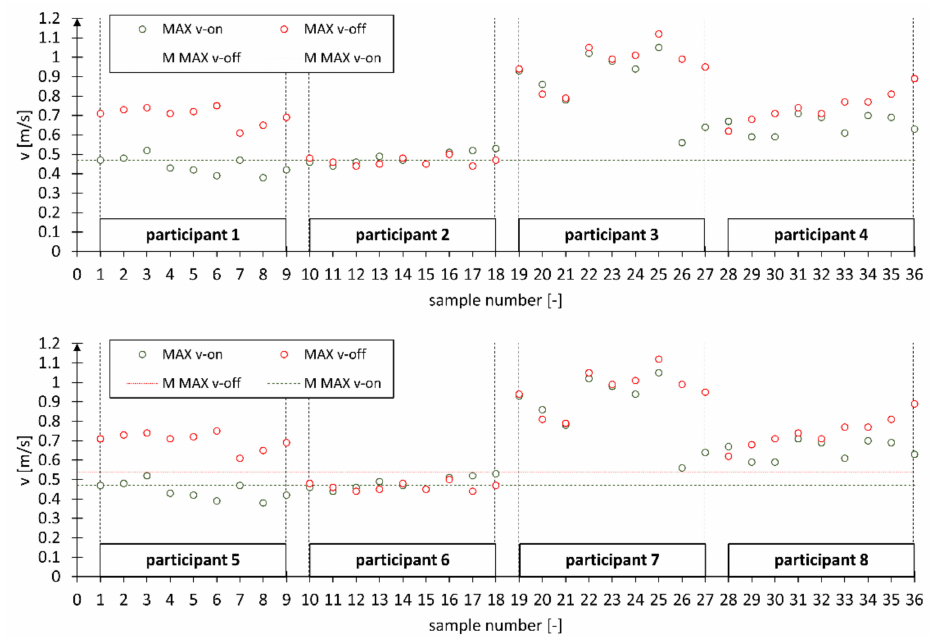
Figure 5. The diagram with the wheelchair maximum velocity for all the analyzed measurement tests, where MAX v-on—wheelchair maximum velocity with the activated anti-rollback system, MAX v-o ff -wheelchair maximum velocity with the deactivated anti-rollback system, M MAX v-on—wheelchair average maximum velocity for all the measurement tests with the activated anti-rollback system, M MAX v-o ff —wheelchair average maximum velocity for all the measurement tests with the deactivated anti-rollback system.